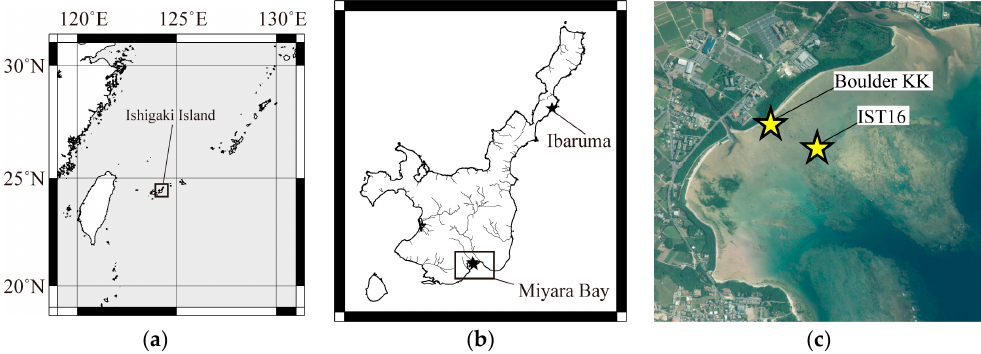
Figure 1. ( a ) Map showing the location of Ishigaki Island; and ( b ) map of Ishigaki Island showing the presence of streams. The black stars indicate the locations of Boulder KK and the cylindrical reef boulder, and the Porites colony on Ibaruma beach. The datasets were downloaded from the National Land Numerical Information download service. ( c ) Aerial photograph of Miyara Bay area, provided by the Geospatial Information Authority of Japan. The stars indicate the location of Boulder KK, and the cylindrical reef boulder.